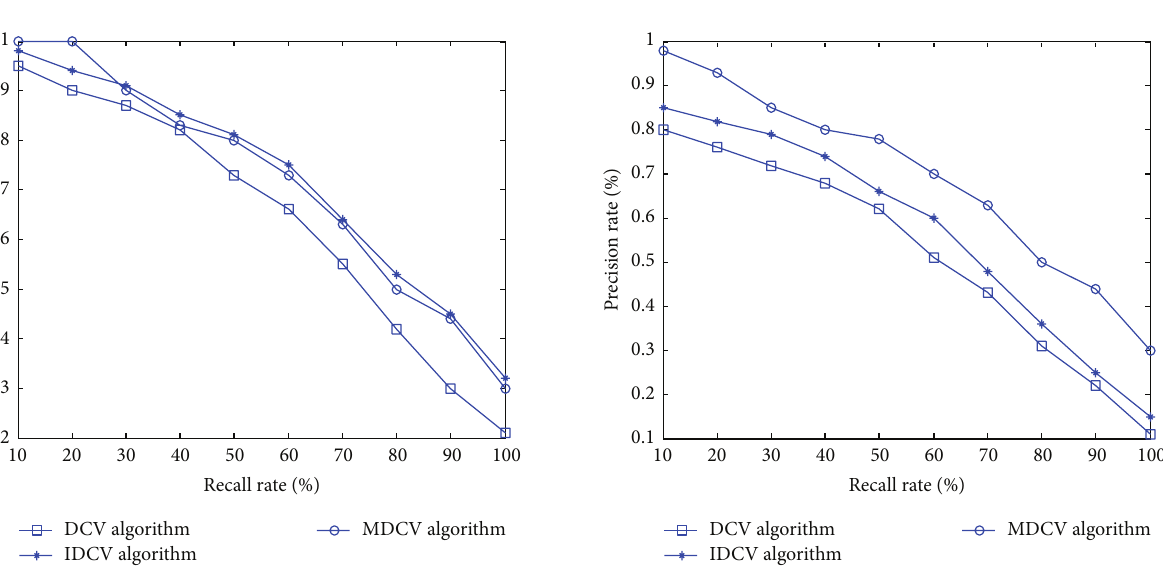
Figure 11: Contrast curves of DCV, IDCV, and MDCV algorithms. Figure 12: Contrast curves of DCV, IDCV, and MDCV